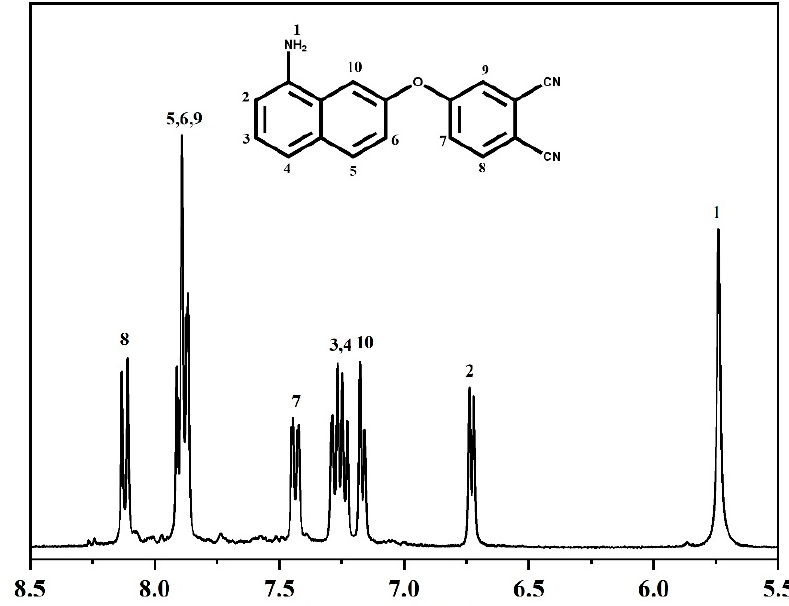
Figure 2. 1 H NMR spectrum of the ANP monomer.